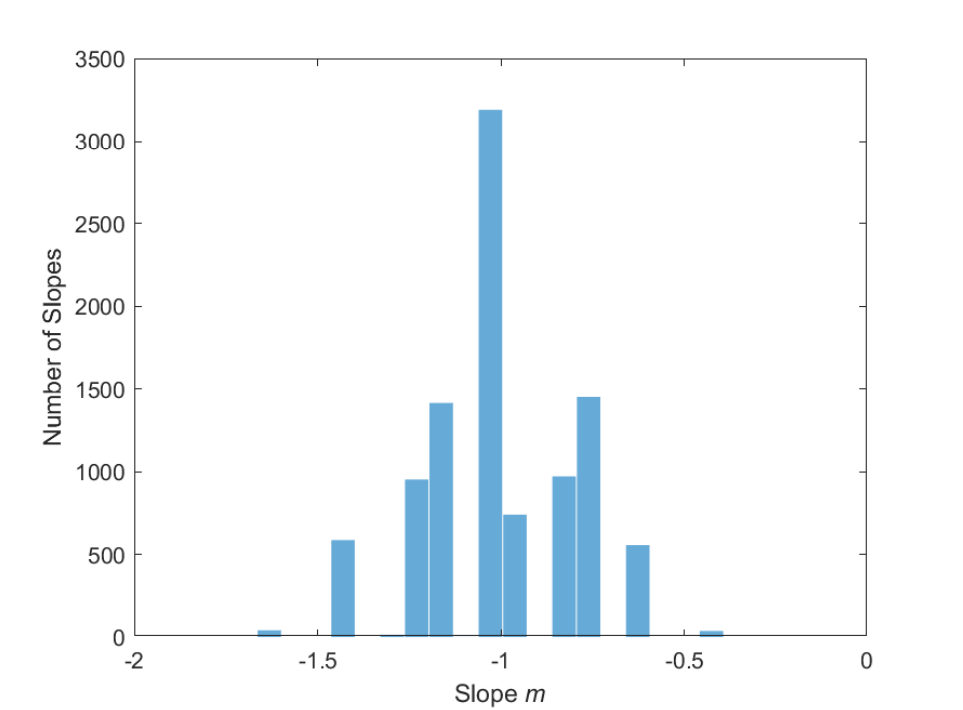
Figure 14. Histogram of 10,000 slopes m measured from log N -log F max diagrams in 10,000 typical simulations of 50 “galaxy” samples each. About 40% of the slopes aggregate at m = − 1, and the majority of slopes (90%) fall to within ± 0.25 of m = −